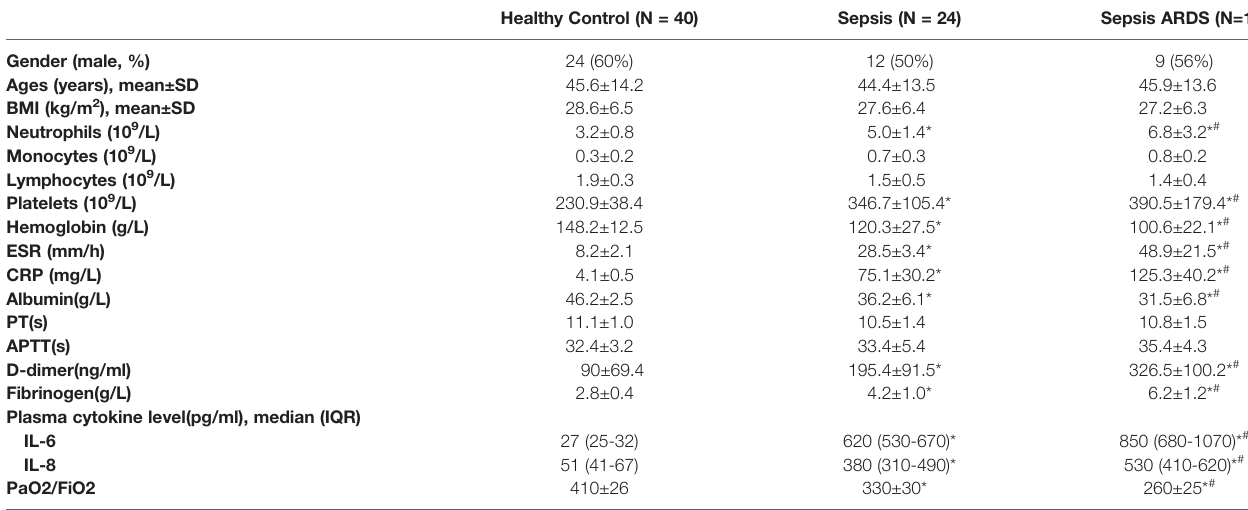
TABLE 1 | Baseline of characteristics of healthy and patients enrolled in the group.